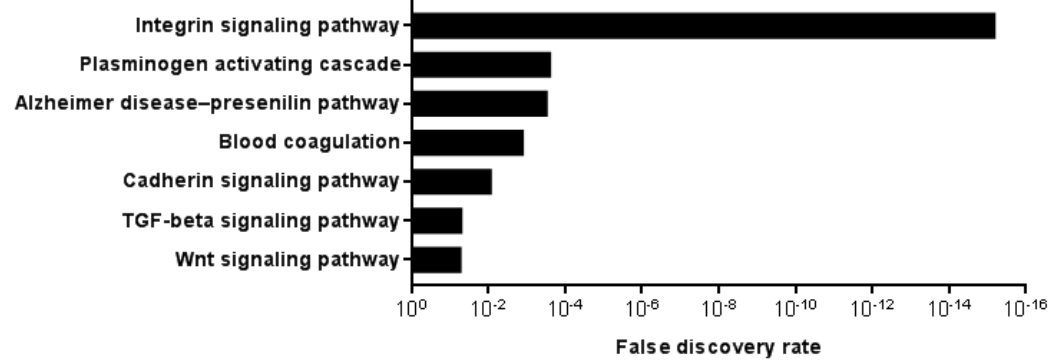
Figure 4. Significantly enriched PANTHER pathways in the higher ( n = 25) versus lower ( n = 25) DCBLD1 expressing participants from the HNSCC TCGA cohort. p values for significance cut-off was calculated using Bonferroni correction. No pathway was significantly enriched in the lower DCBLD1 participants.